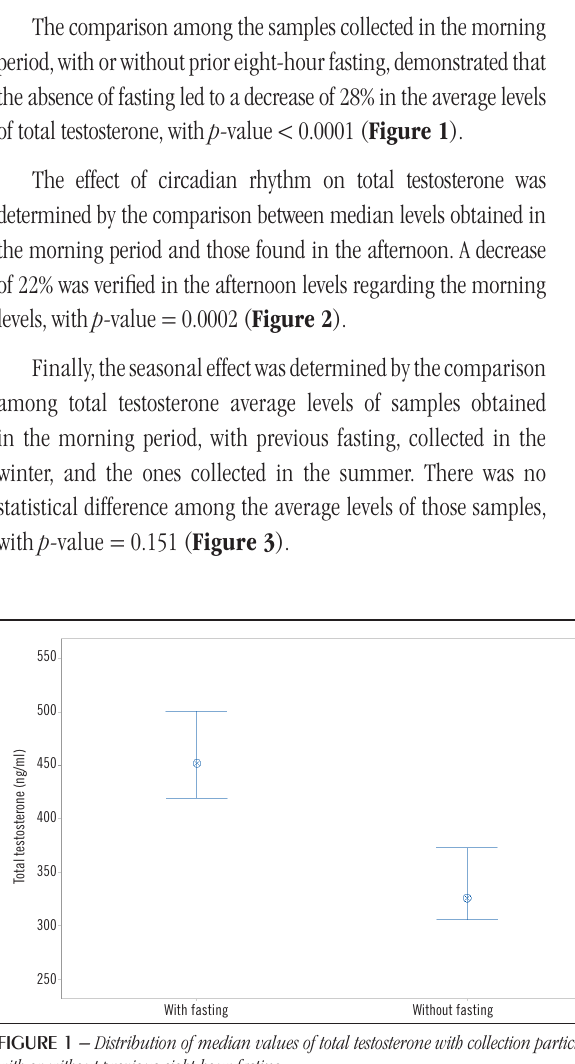
with or without previous eight-hour fasting